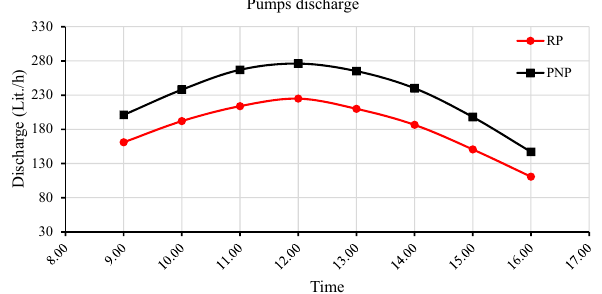
Figure 18. The RP and PNP discharge after self-cleaning with water.